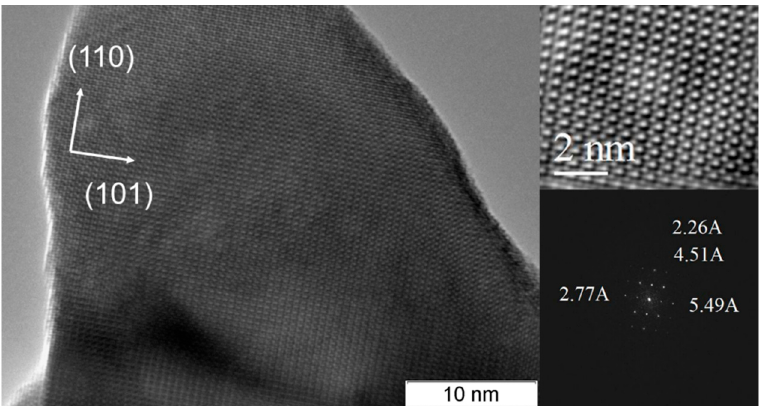
Figure 4. HRTEM image of the LaMn 0.2 Fe 0.8 O 3 microstructure after methane oxidation; FFT image illustrates duplication of the unit cell period along the (100) and (101) planes.